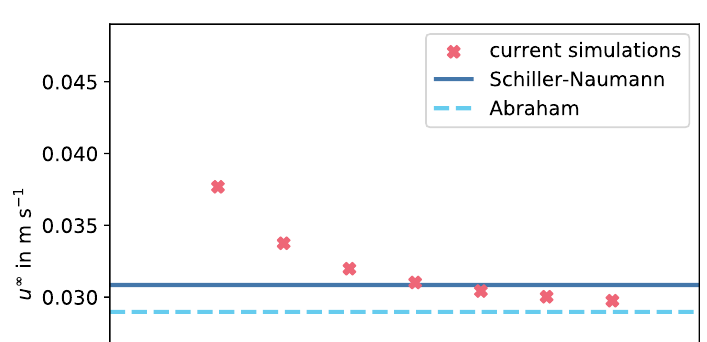
Table 7. Maximum settling velocity for µ f = 0.005kgm − 1 s − 1 for a chosen lattice velocity u L (see Equation (27)). Also given is the deviation to the velocity obtained with u L = 0.0025 and the change of maximum velocity to the value obtained with the next smaller u L .